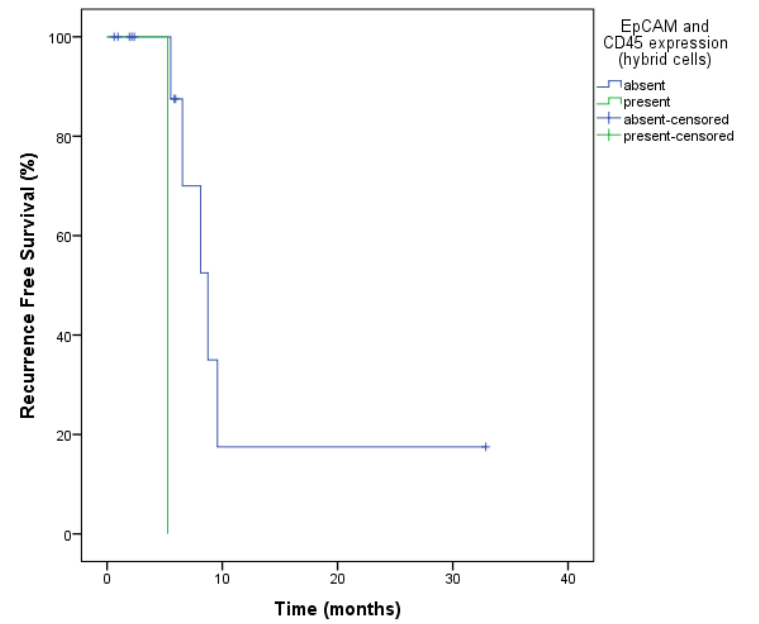
Figure 3. Recurrence-free survival analysis of ovarian cancer patients for EpCAM and CD45 expres- sion in hybrid cells at the baseline and at second follow-up. The expression of this markers showed a worse RFS of 5.26 months vs. 12.2 ( p = 0.005) in relation to those who did not.